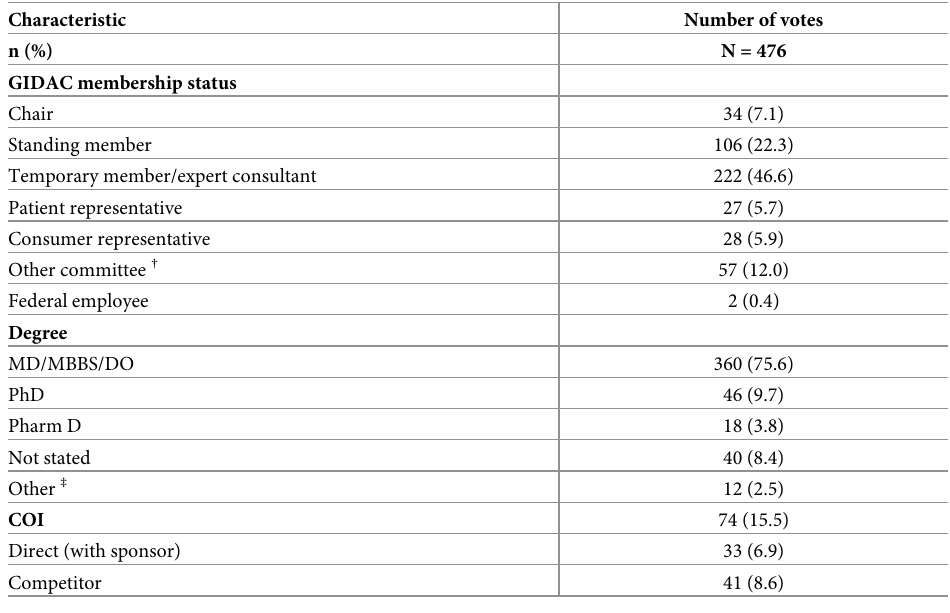
Table 4. Medication approval voting